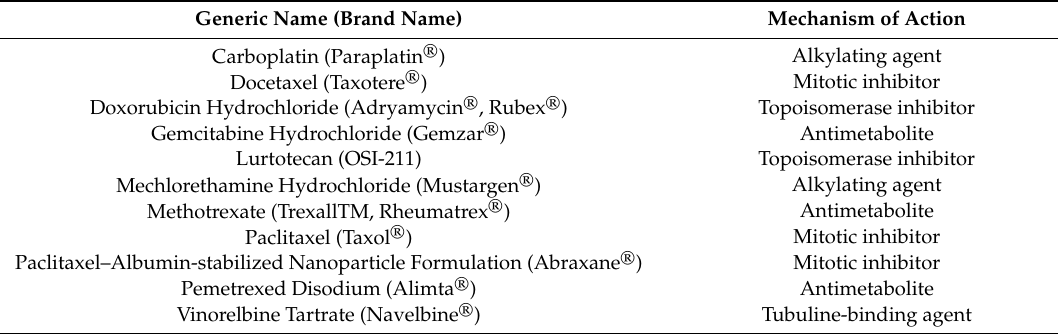
Table 3. Food and Drug Administration (FDA)-approved chemotherapy drugs for the treatment of NSCLC. Sources, FDA and National Cancer Institute databases [55,56].